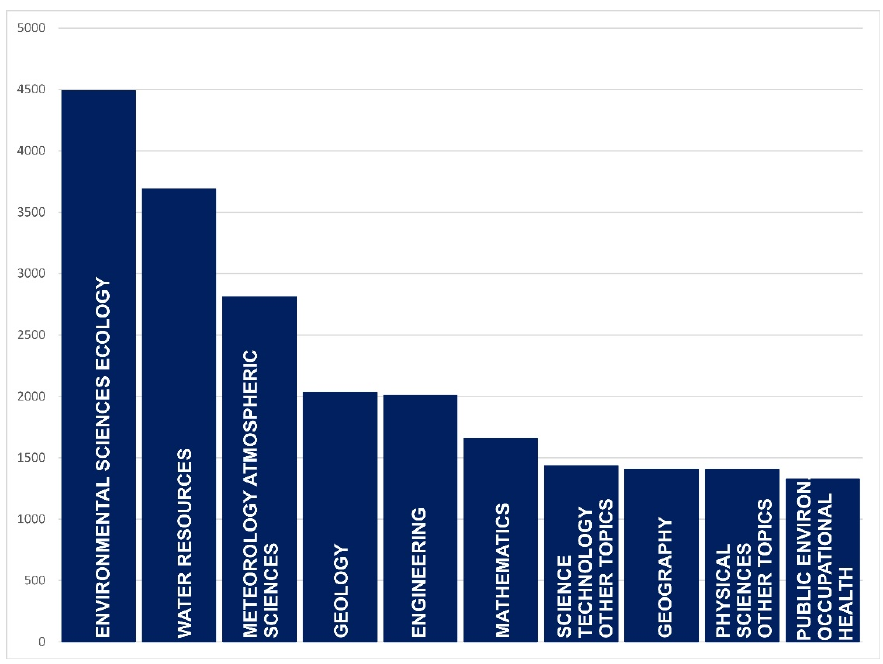
Figure 3. Bar chart showing the number of FRAs references (records) in WoS databases classified by ‘Research Areas’, indicating the ten main